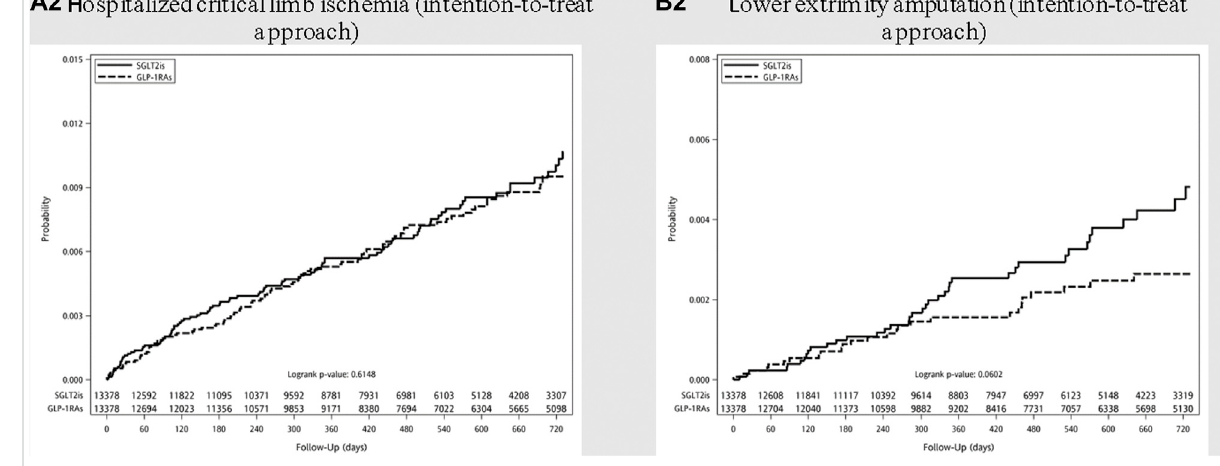
FIGURE 2 Cumulative incidence curves of (A) hospitalized critical limb ischemia and (B) lower extremity amputation among diabetes patients initiating sodium-glucosecotransportertype-2inhibitors(SGLT-2i)andglucagon-likepeptide1receptoragonists(GLP-1RA)afterpropensityscorematching. (On treatment approach: A1 and B1; Intention-to-treat approach: A2 and